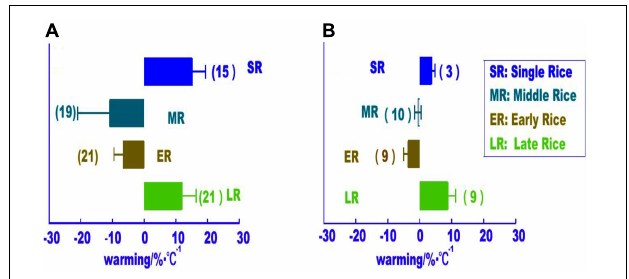
FIGURE 2 | Effects of climate warming on rice yield per unit area in different rice cropping systems. (A) Observational data from long-term field trials; (B) analysis based on provincial statistical data. Error bars indicate standard errors (modified from Lv et al., 2018).